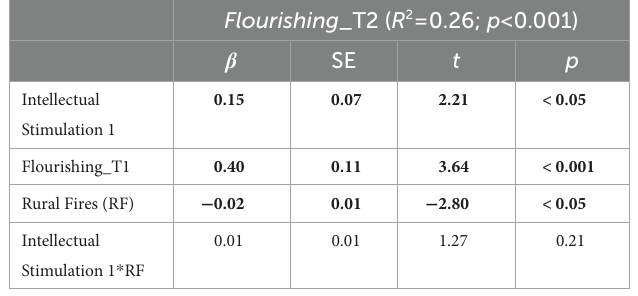
TABLE 4 Analysis of the effect and moderation between the variables under study—intellectual stimulation dimension.